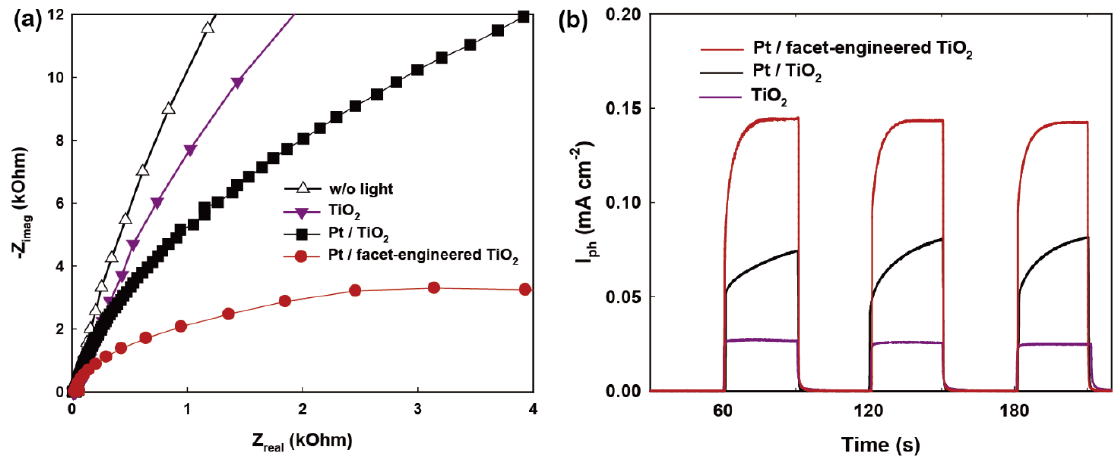
Figure 4. ( a ) Nyquist plots of prepared photocatalysts coated onto ITO from 1 MHz to 0.01 Hz at